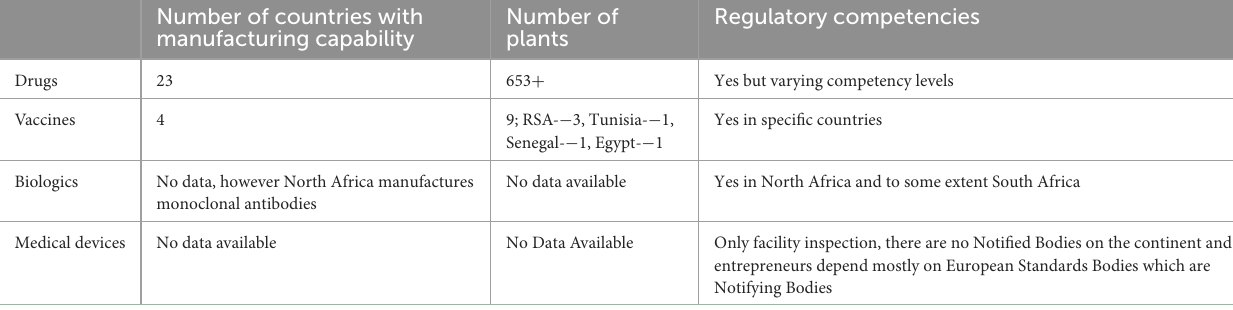
TABLE 1 State of regulatory competencies for drugs, vaccines, biologics, and medical devices. Number of countries with manufacturing